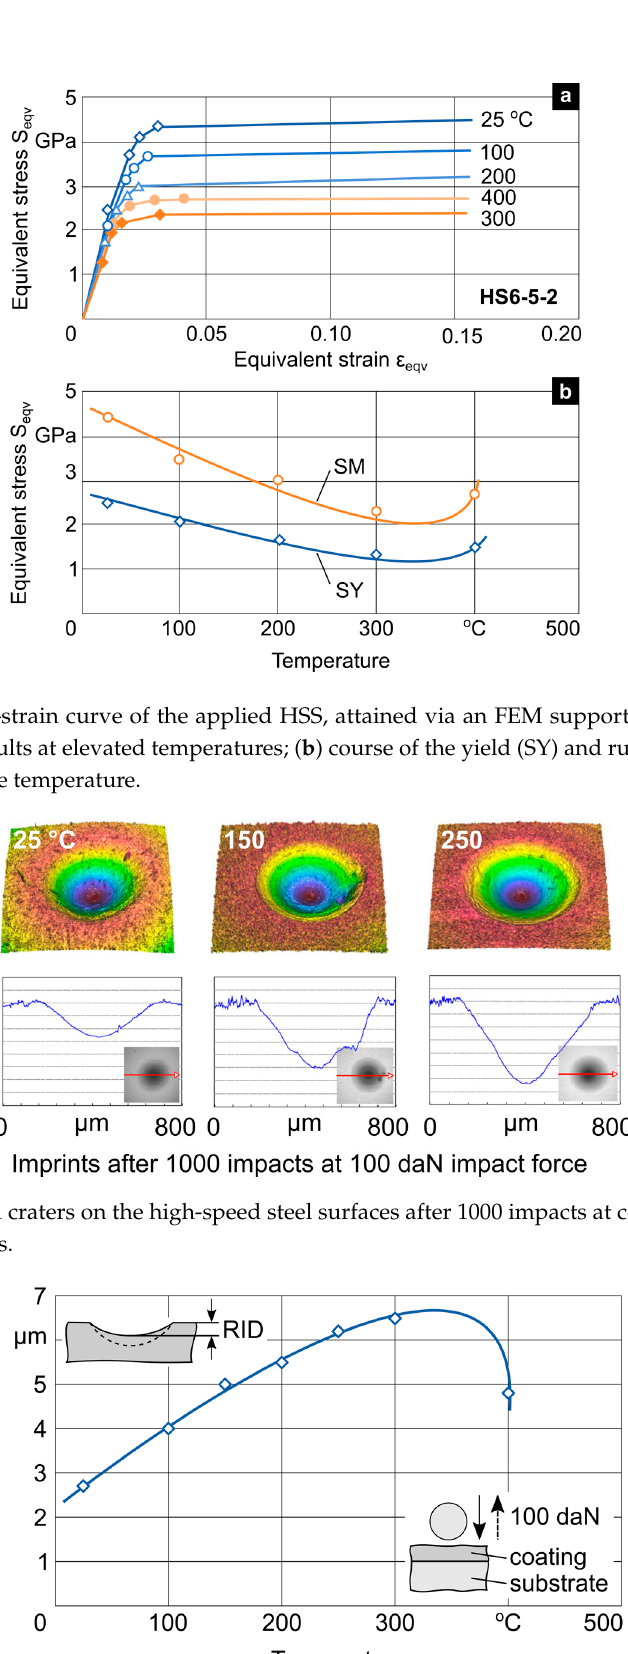
Figure 6. Remaining imprint depth (RID) after 1000 impacts at constant impact force versus the temperature.